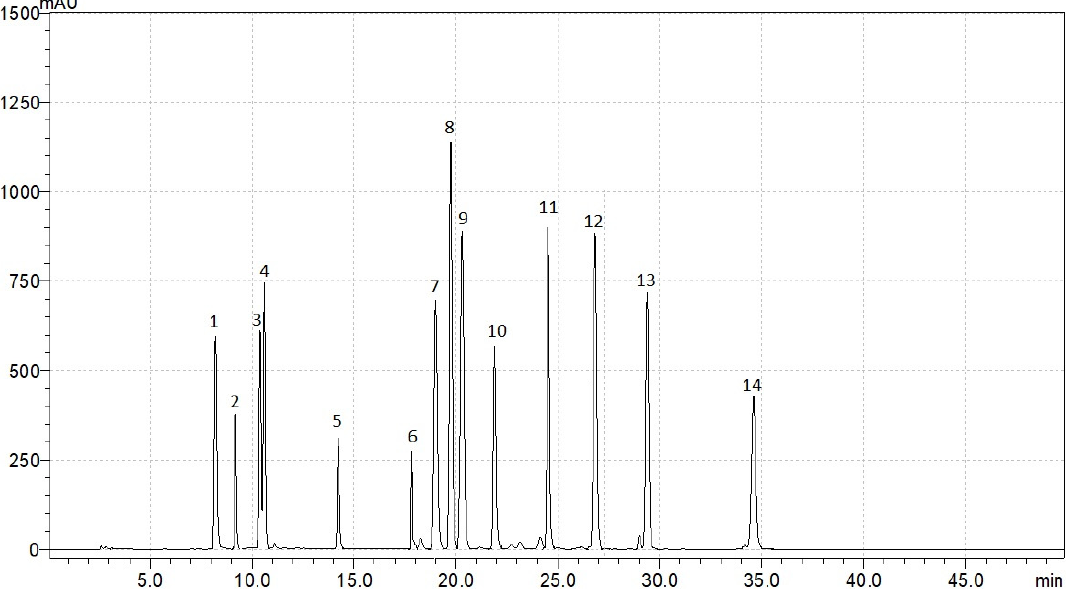
Figure A2. Chromatographic profile of the phenolic acids and flavonoids at 340 nm for standard mixture: 1—sinapic acid, 2—caftaric acid, 3—chlorogenic acid, 4—caffeic acid, 5—p-coumaric acid,